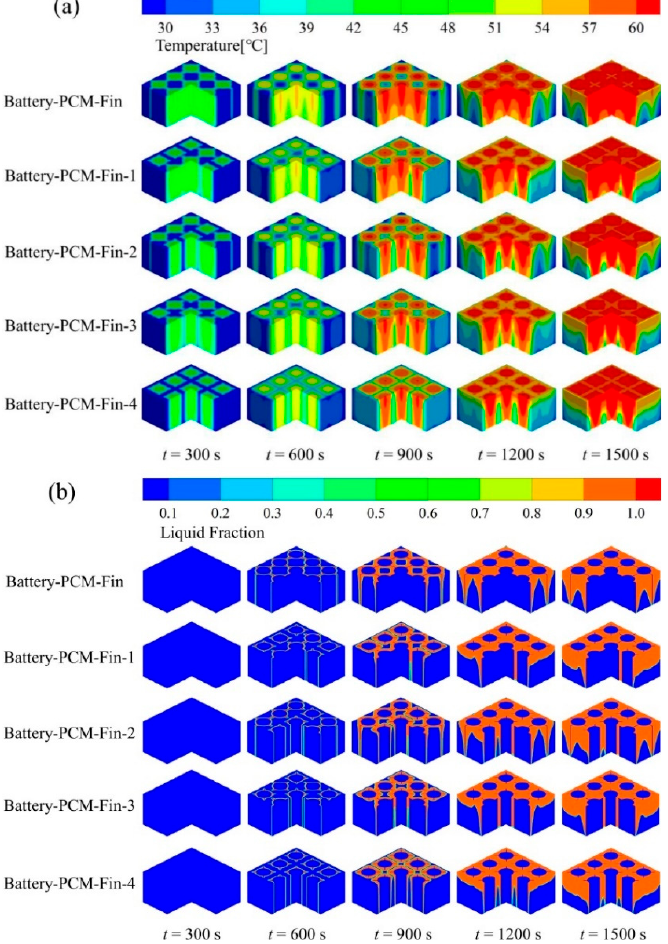
Figure 12. Numerical simulation of the temperature field ( a ) and liquid fraction ( b ) for the fin layouts presented in Figure 11. Reproduced from [54] with permission from Elsevier.